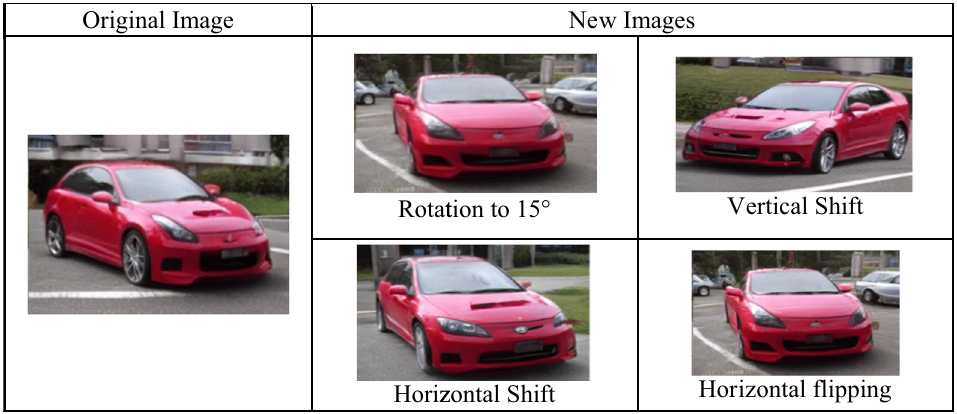
Figure 4: Result of augmentation process.